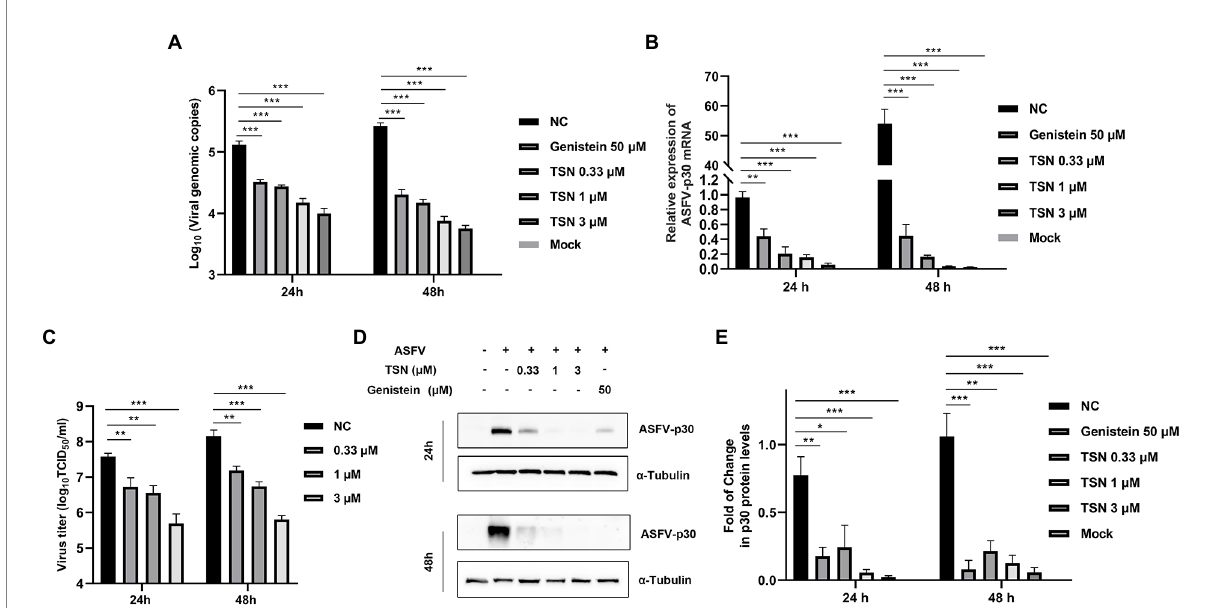
FIGURE 2 TSN exhibits continuous inhibition on ASFV replication in a dose-dependent manner in PAMs. PAMs seeded in 24-well or 48-well plates were infected with ASFV (0.014 MOI) at 37 ° C for 2 h and then washed with PBS and cultured in a fresh maintenance medium containing different concentrations of TSN. At 24 and 48 hpi, the samples were subjected to qPCR, RT-qPCR, Western Blot and viral titer analysis. (A) The DNA level of the ASFV p72 gene was analyzed using qPCR. (B) The mRNA level of the ASFV p30 gene was analyzed using RT-qPCR. (C) The ASFV titer was determined at 24 and 48 hpi using the endpoint dilution method as described in the Methods. (D) The expression of viral p30 protein in PAMs treated with TSN or Genistein was detected by Western Blot. Genistein (50 μ M) was used as a positive control. (E) The densitometric analysis of p30 from (D) was performed using the ImageJ software and data were normalized by comparing to the virus control (NC) at 48 h (set as 1). *** denotes p < 0.001; ** denotes p < 0.01; * denotes p < 0.05. NC denotes the negative control (only ASFV infection without TSN